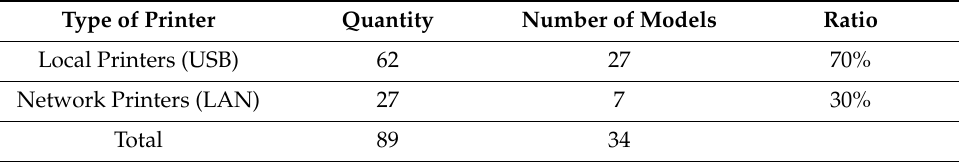
Table 2. Proportion of di ff erent types and models of